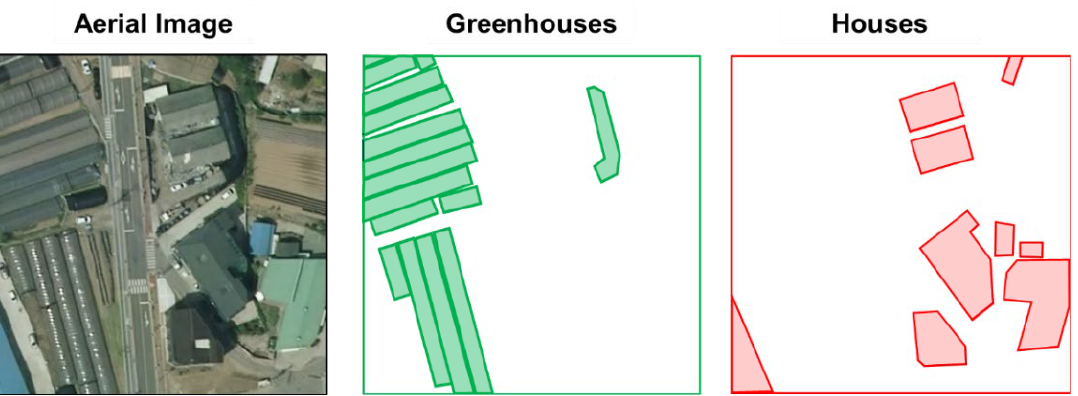
Figure 1. Object information extracted from an aerial photograph, including greenhouse structure and residence annotations.